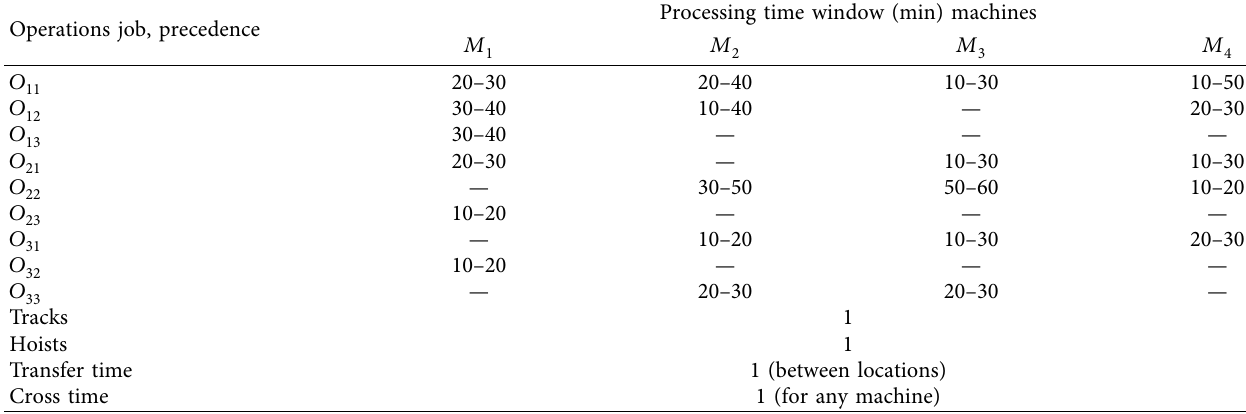
Table 1: An MHSP example. Processing time window (min)